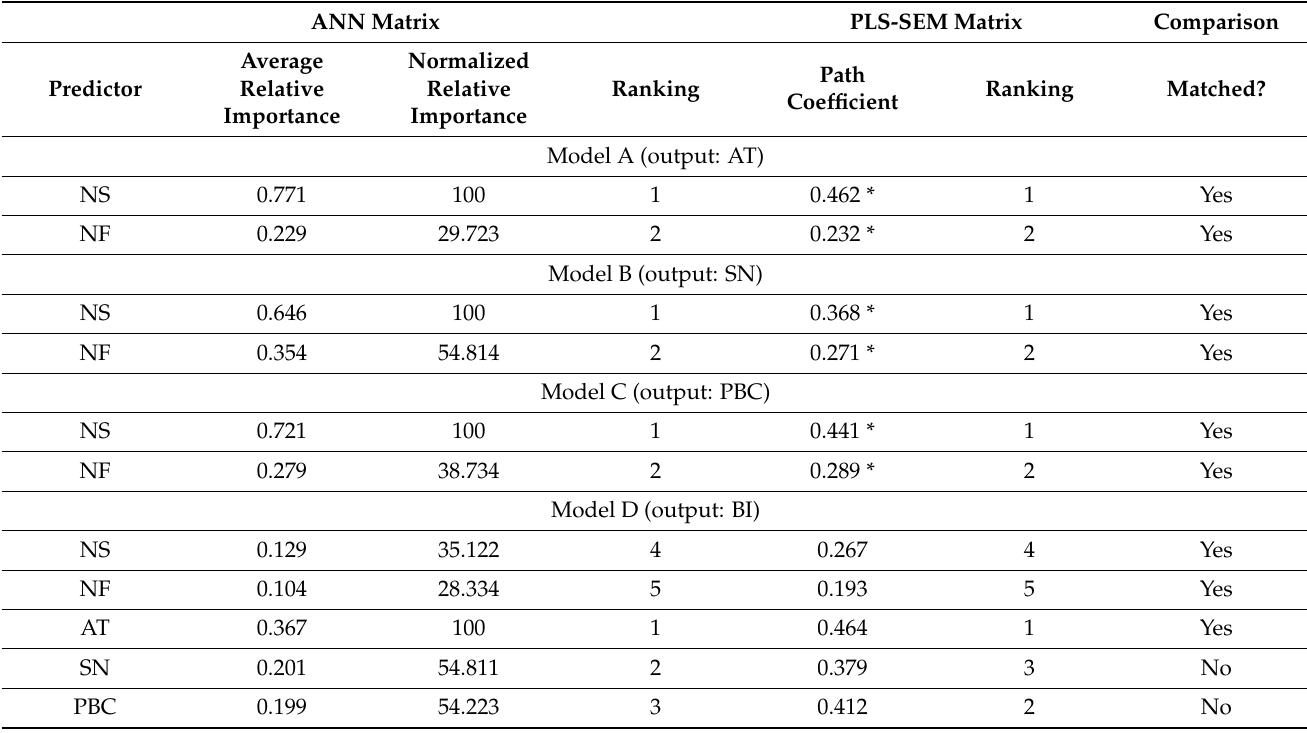
Table 7. Comparison of PLS-SEM and ANN